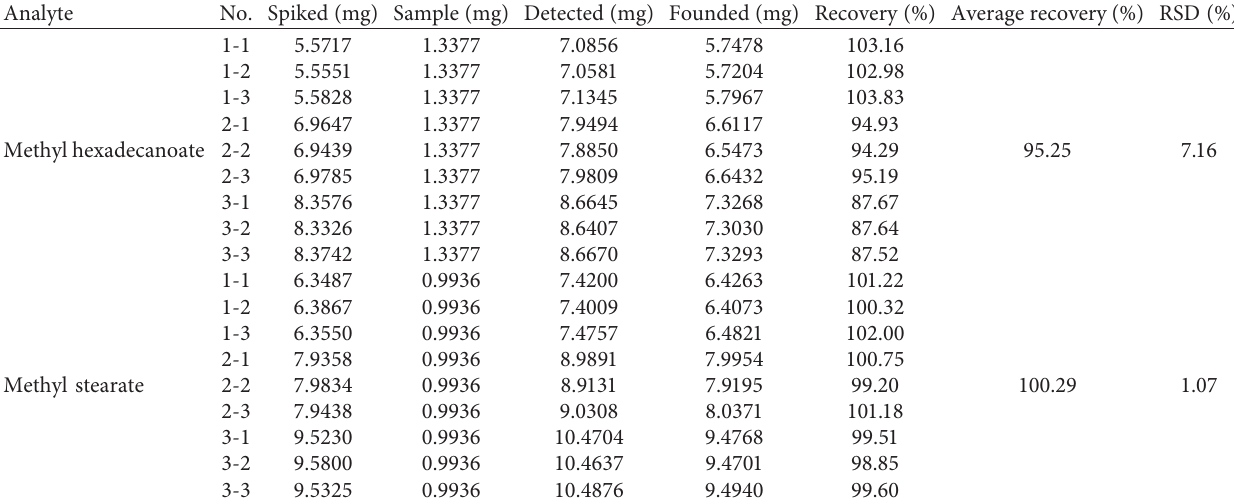
Table 2: Recoveries of methyl hexadecanoate and methyl stearate in liposome injections.